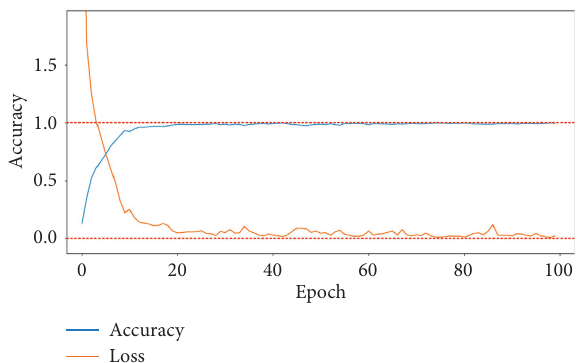
Figure 10: DCTCN model training accuracy.